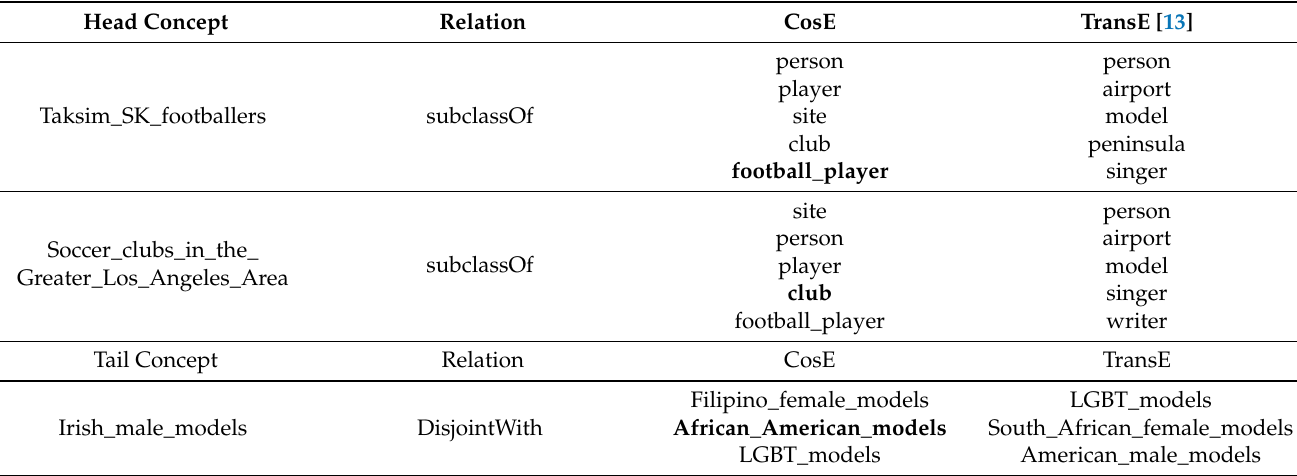
Table 9. The examples of predicted results on CosE compared with